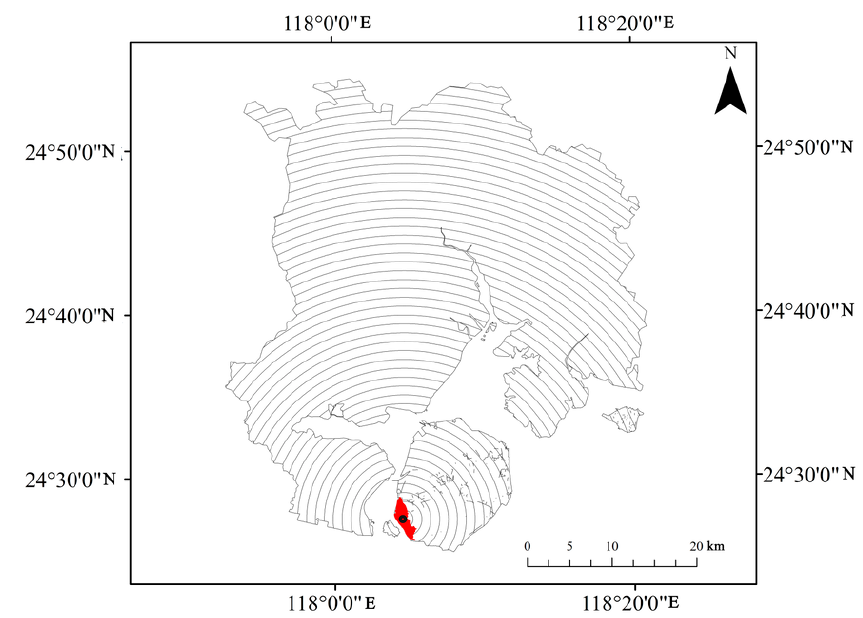
Figure 4. Study area and buffer zone construction.